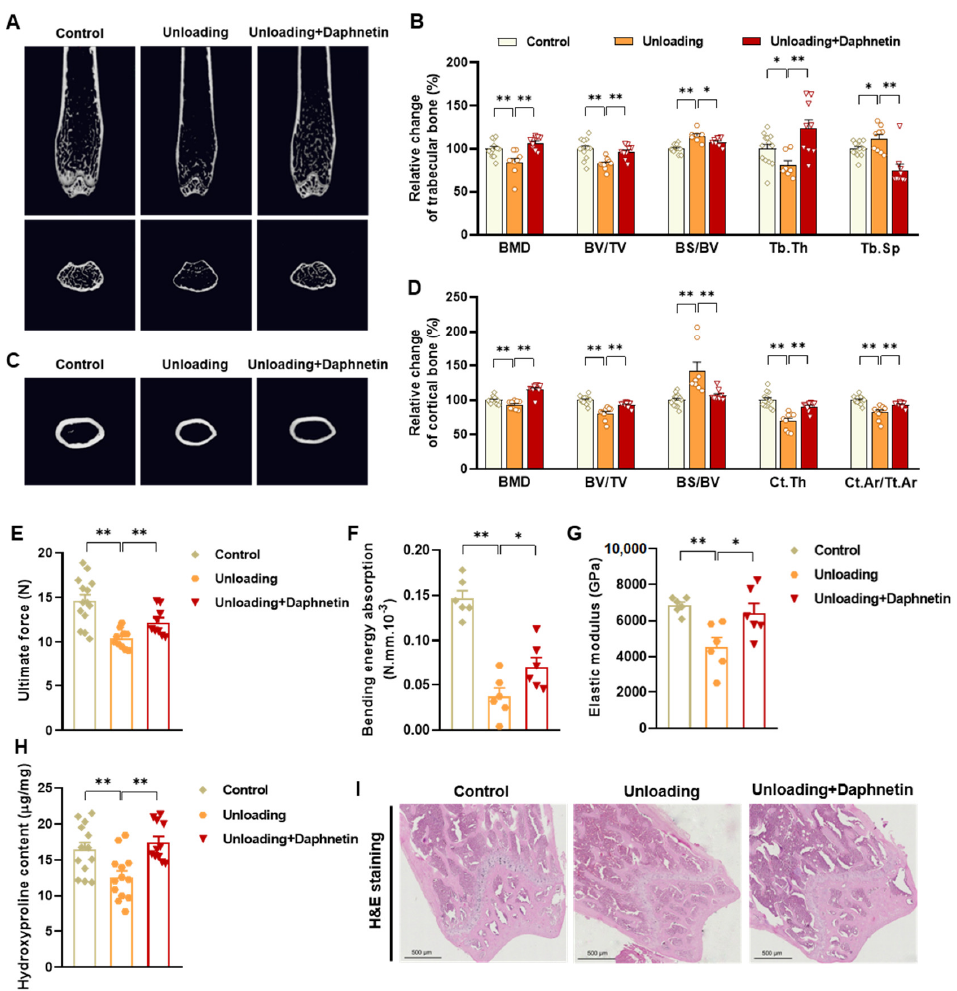
Figure 2. Protective effects of daphnetin against disuse osteoporosis in hindlimb unloading mice. ( A ) Micro-CT images of trabecular bone in distal femur. ( B ) Trabecular BMD, BV/TV, BS/BV, trabecular thickness (Tb. Th) and trabecular spacing (Tb. Sp) were calculated from the micro-CT data. ( C ) Micro-CT images of cortical bone in mid-diaphysis femur. ( D ) Cortical BMD, BV/TV, BS/BV, Ct.Th, and Ct. Ar/Tt. Ar were calculated from the micro-CT data. To evaluate femoral mechanical properties, ultimate force ( E ), bending energy absorption ( F ), and elastic modulus ( G ) were determined by three-point bending test. ( H ) Hydroxyproline content of femur was determined with commercial kit. ( I ) Femur sections were prepared, and H & E staining was performed. Data are mean ±S.E.M. ( n ≥ 6); * p < 0.05; ** p < 0.01.